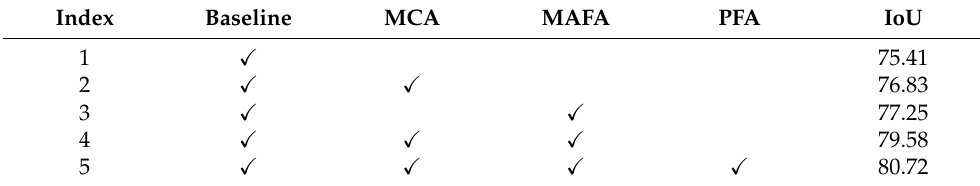
Table 3. Ablation results on the World-Cover